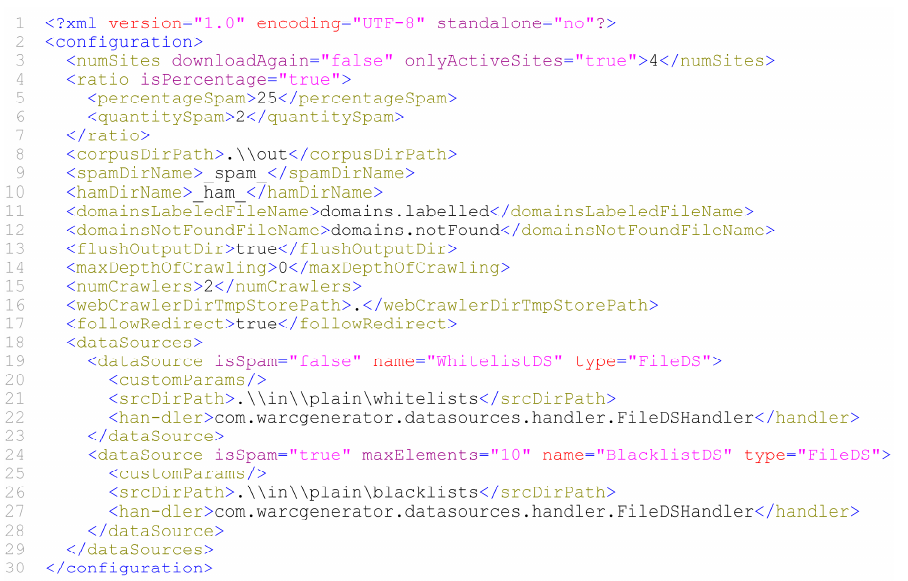
Figure 7. Snippet of a valid WARCProcessor configuration file.